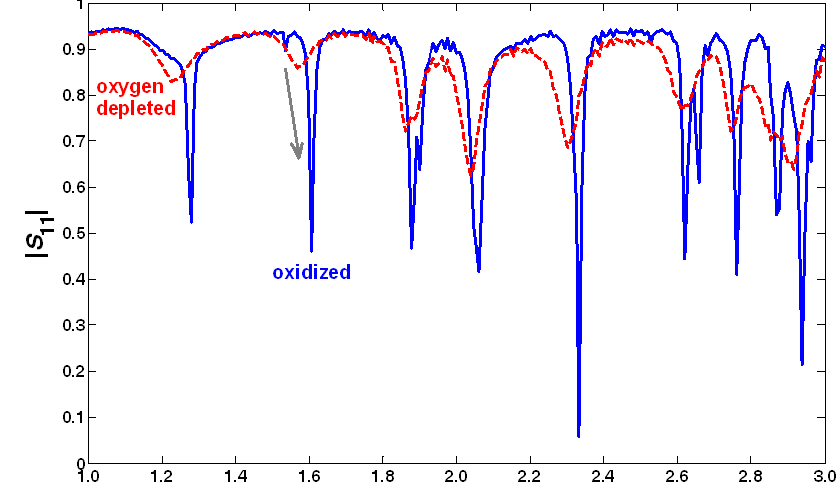
Figure 7. Spectrum of the input reflection coefficient of a TWC when fully oxidized or oxygen-depleted (engine test; T ≈ 450 °C, space velocity 60,000 h −1 , catalyst size approx.  118 mm  127